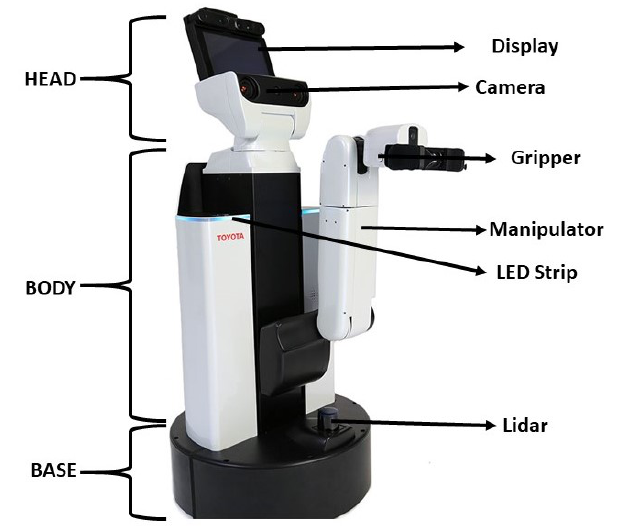
Figure 8. HSR robot System.